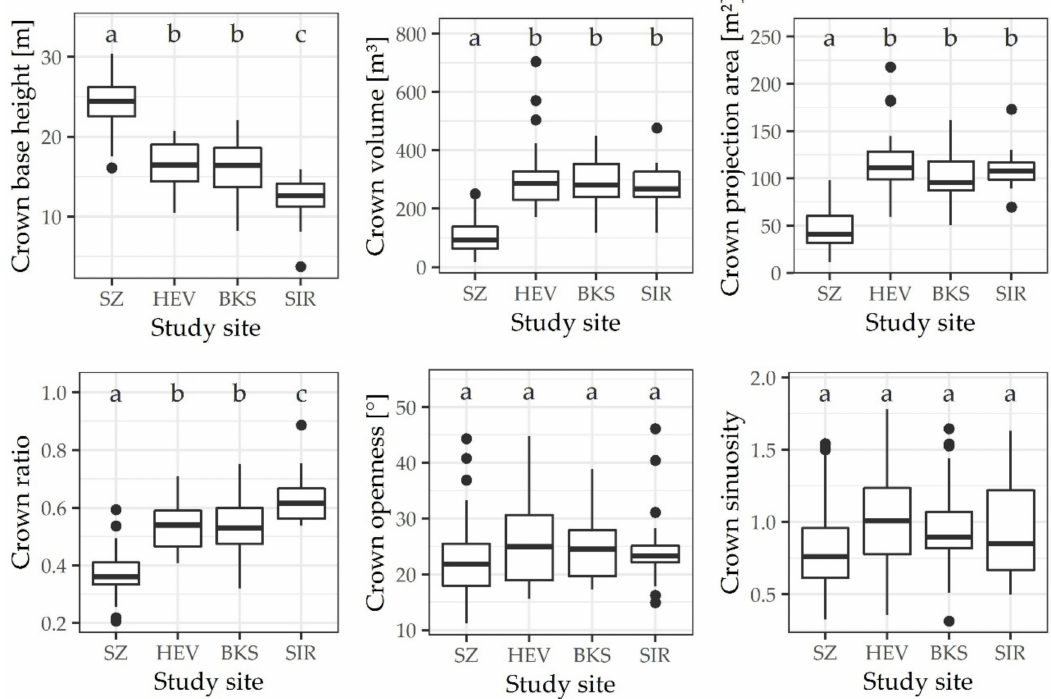
Figure 4. Variation in crown morphological traits between the stands along the management gradient. Different letters indicate significant differences (Tukey-HSD, p < 0.03) between study sites SZ = Schattiner Zuschlag (long-term unmanaged), HEV = Hevenbruch (short-term unmanaged), BKS = Berkenstrücken (extensively managed), SIR = Sirksfelder Zuschlag (intensively managed).